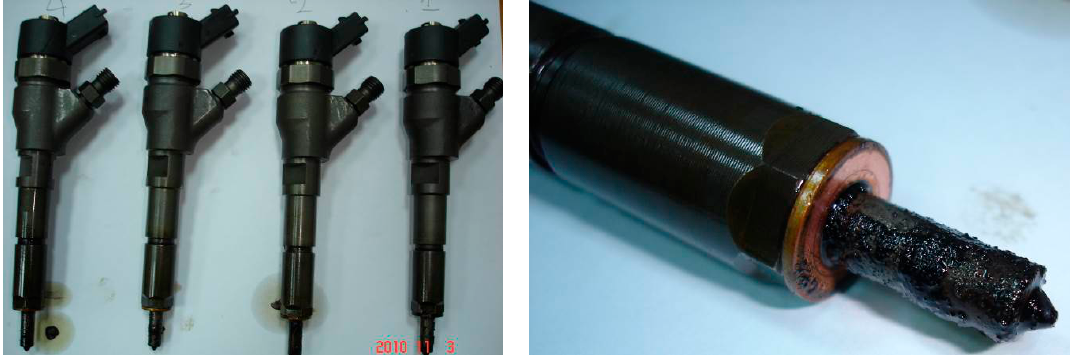
Figure 10. Used common-rail injectors ( left ) and closer view of the deposits ( right ).